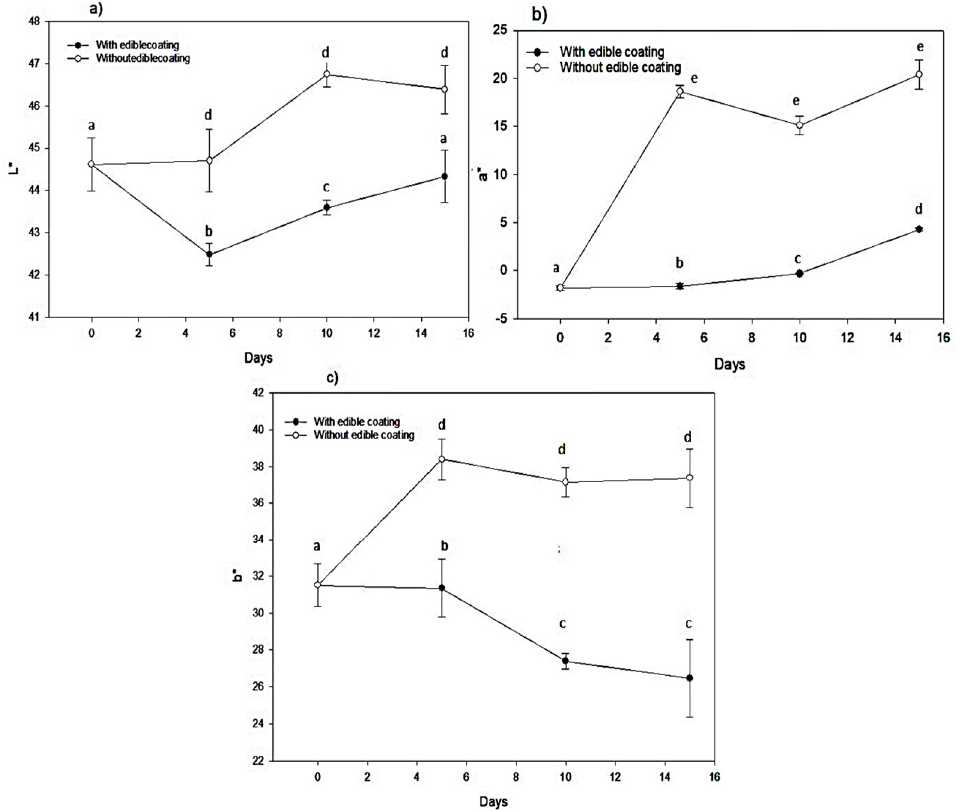
Figure 4. Papaya color changes in storage with and without edible coating: ( a ) L *; ( b ) a *; ( c ) b *. a–d: used on top of reported values, indicate that if the same letter appears at different times, the values compared are not significantly different ( p > 0.05). Table 1. Volatile compounds generated during papaya ripening with and without edible